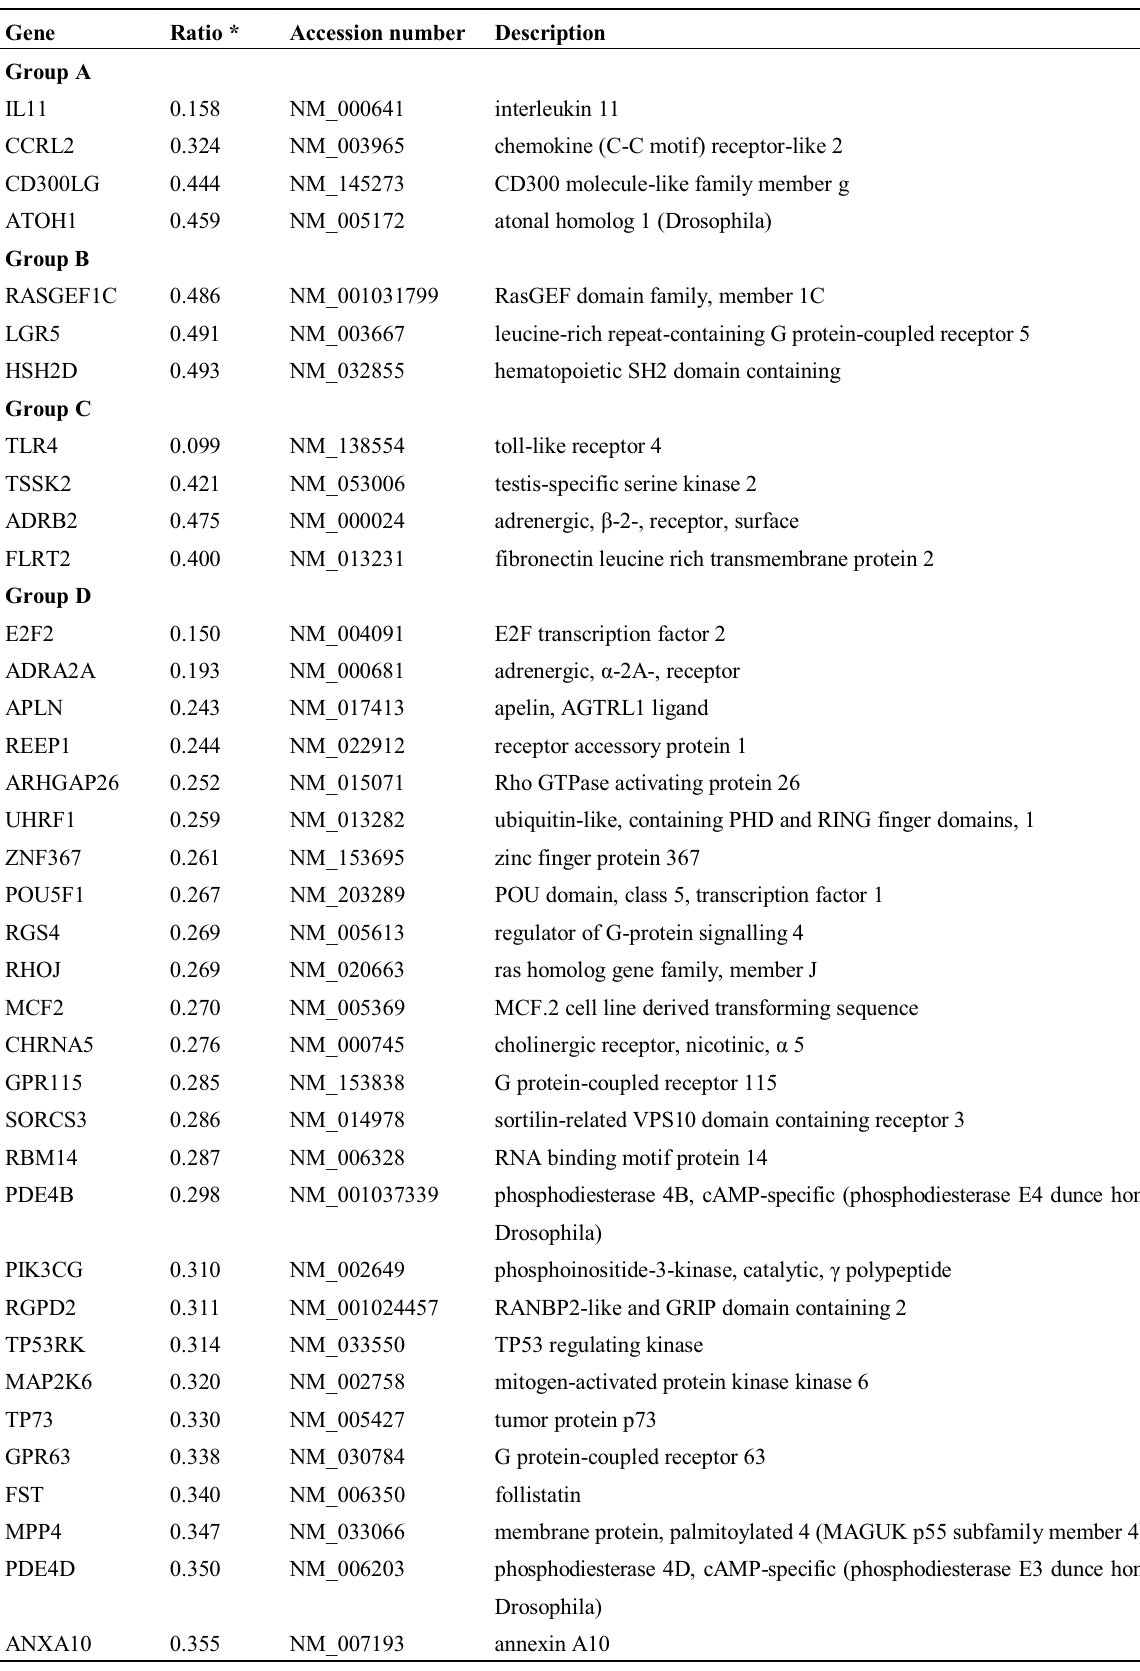
Table 7. Genes encoding receptors, signal proteins, transcription factors, cytokines, and growth factors whose expression was repressed at pH